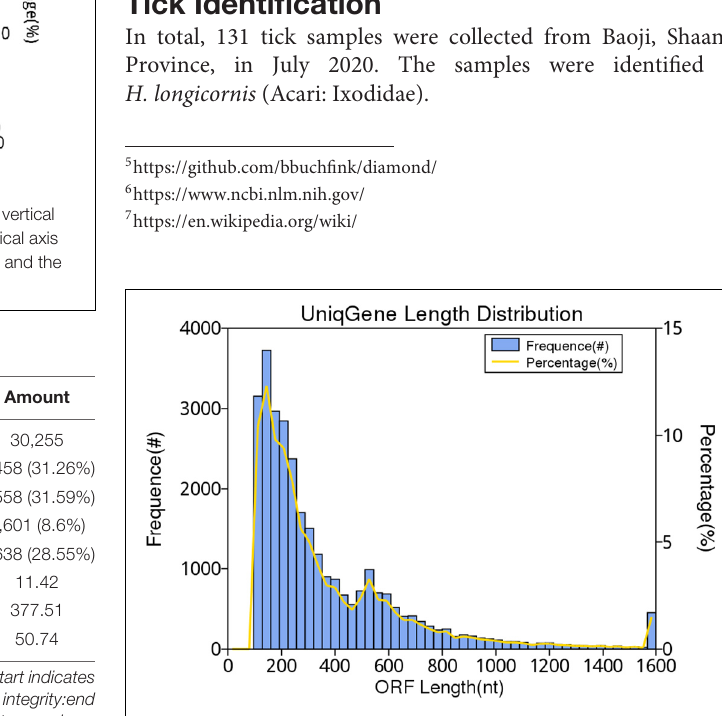
FIGURE 4 | Gene catalog length distribution. The first vertical axis frequency (#) indicates the number of genes in the catalog, the second vertical axis percentage (%) represents the percentage of the number of genes in the catalog, and the horizontal axis indicates the length of the gene in the gene